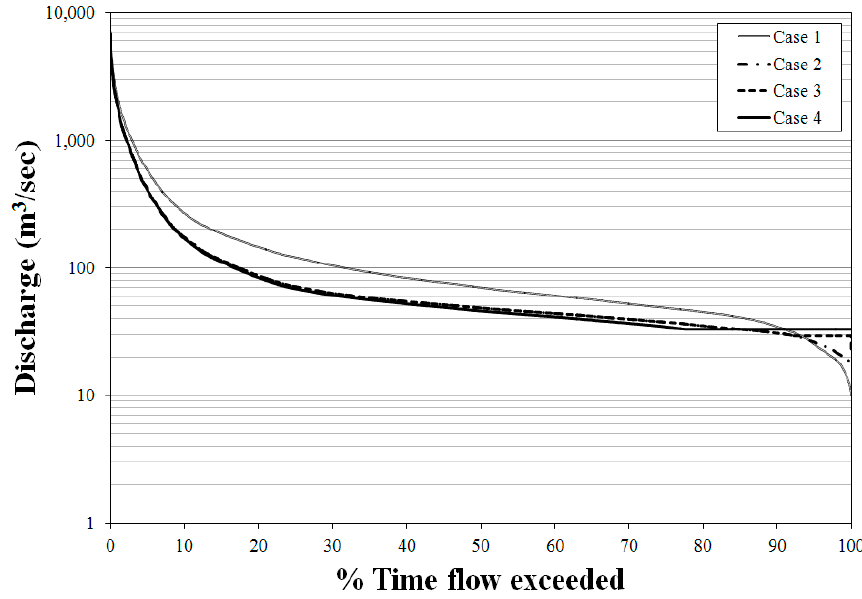
Figure 7. Flow duration curves according to different operation scenarios at Gyuam point.